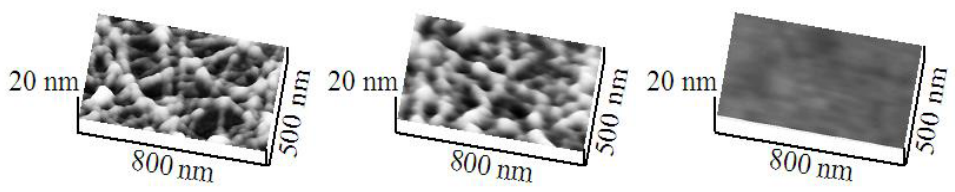
Figure 6. CM-AFM imaging of C6-(YEHK)x21-H6 fibrils on a Au substrate after forced-scan with a tip contact force of 0 nN (left), 38 nN (center) and 90 nN